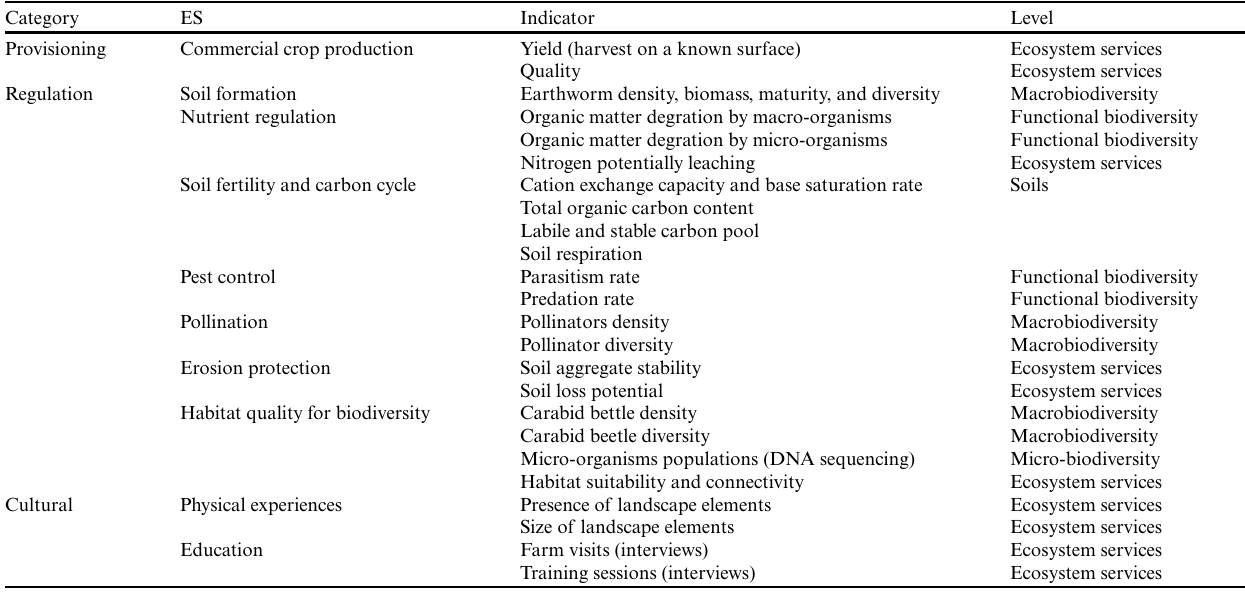
Table 1. Example of how information gathered at different levels can feed integrated valuation of ES